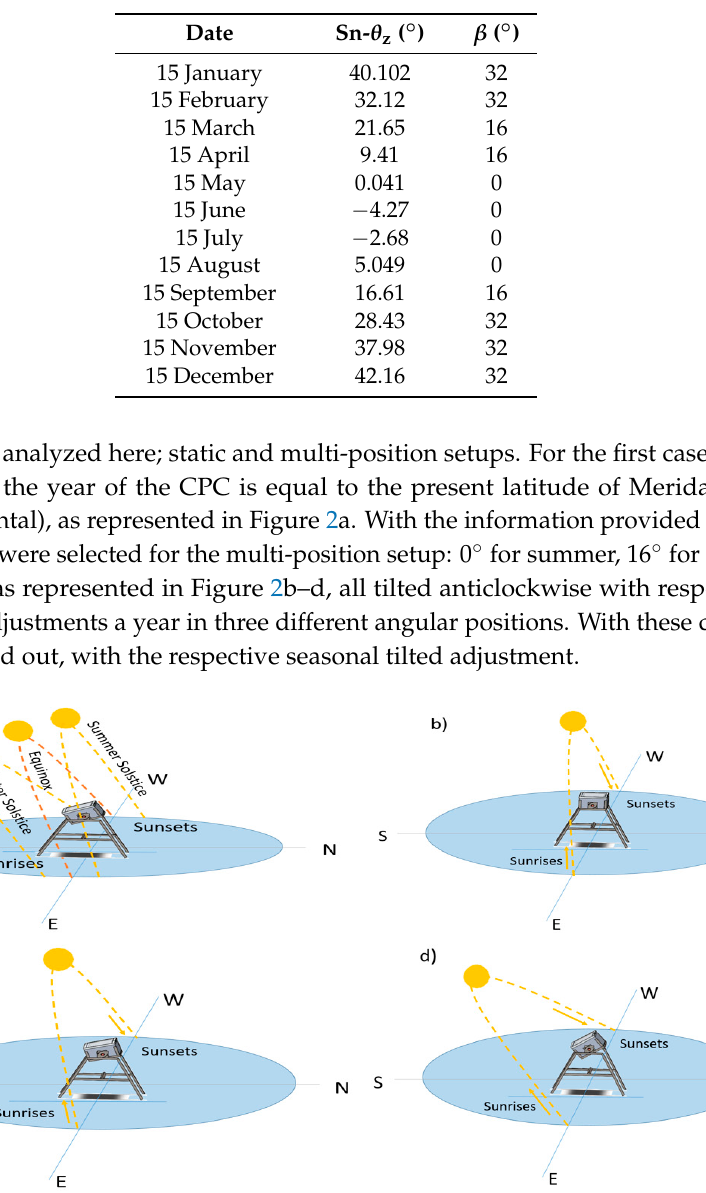
Table 1. Merida solar angle (Sn- θ z ).